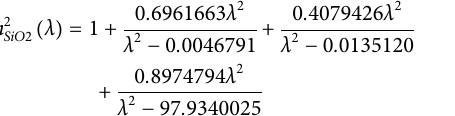
Figure 1 is a 2D cross-sectional view of the proposed D-shape dual side-polished (DSP) PCF-SPR sensor with high sensitivity. It consists of 12 air holes, of which the inner air holes are arranged in a regular hexagonal structure, and the distance between adjacent air holes in the PCF is Λ . The diameter of the 6 small air holes in the inner layer is d 1 , and the diameter of the 6 air holes in the outer layer is d 2 . Both sides of the D-shape PCF are ground and polished surfaces, and the ground and polished surfaces are coated with gold nano- fi lms and TiO 2 fi lms. In order to improve the calculation accuracy, a perfectly matched layer (PML) is added to the outer wall of the fi ber. The substrate